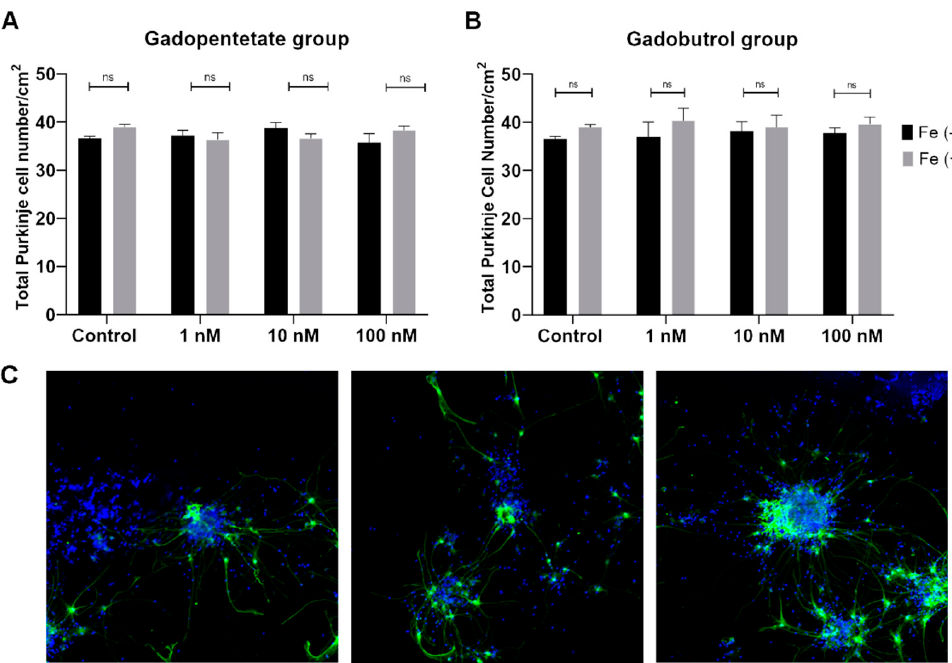
Figure 1. Total Purkinje cell number of the ( A ) gadopentetate group and ( B ) gadobutrol group. There were no differences in cell number among all treated groups when compared to the control group. ( C ) Representative images of the cells at low magnification (10 × ). ns: not significant.